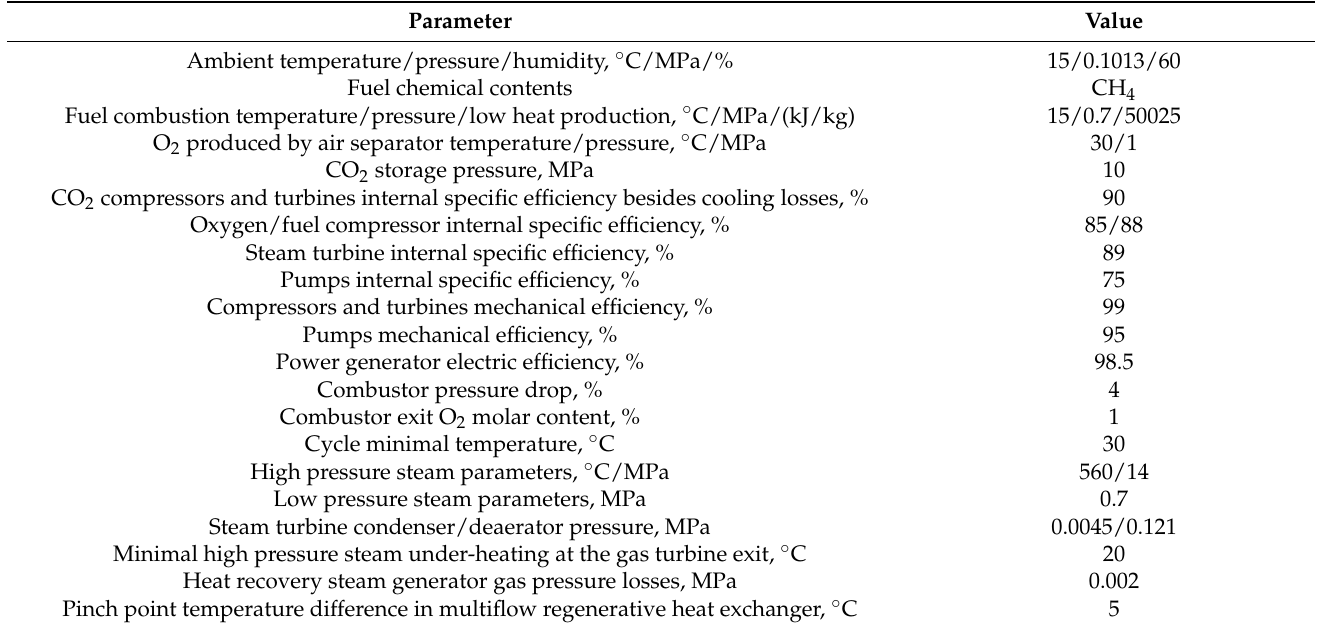
Table 1. Input data used for the computer simulation of oxy-fuel combustion power cycles.